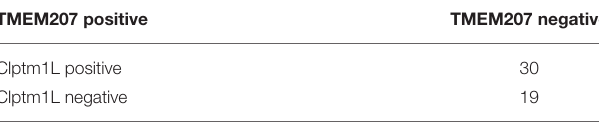
TABLE 2 | Relation of Clptm1L and TMEM207 expression in